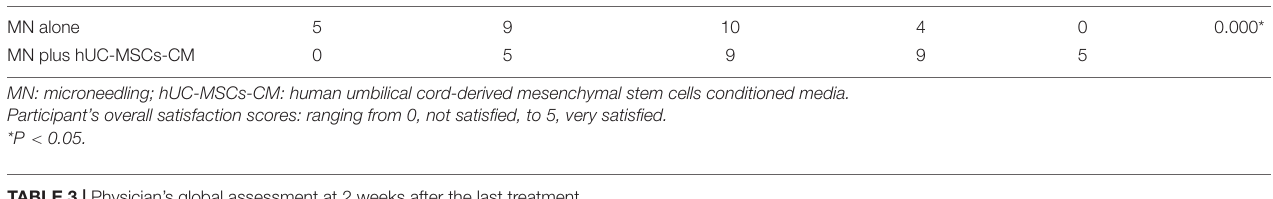
TABLE 3 | Physician’s global assessment at 2 weeks after the last treatment. No or minimal